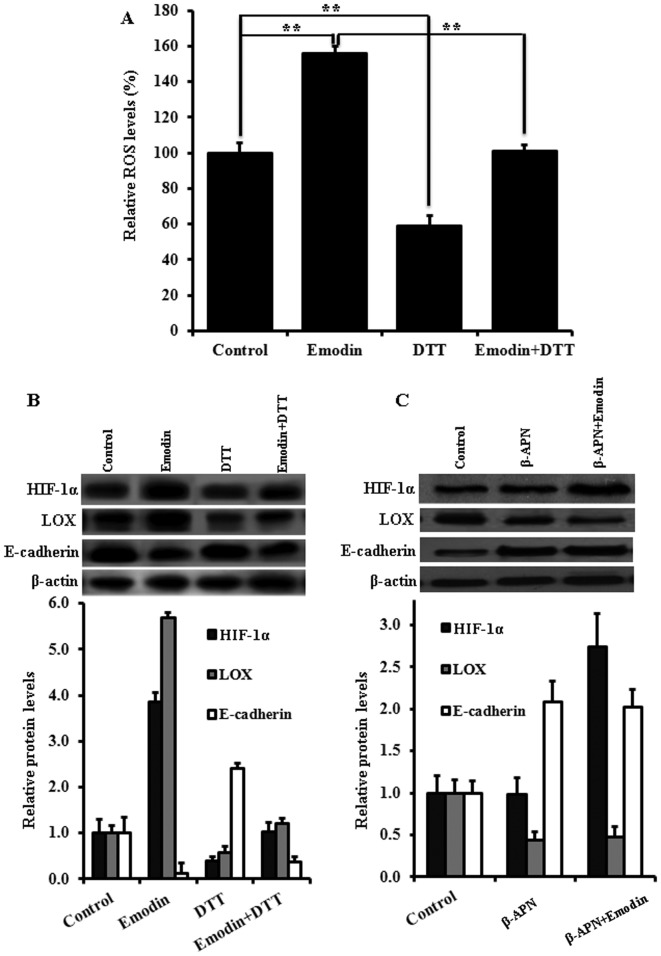
Effect of ROS on HIF-1α, LOX and E-cadherin expression. (A) Assessment of intracellular ROS production in SKOV-3 cells using DCFH-DA method. Cells were treated with 50 μM emodin for 4 h or 5 mM DTT for 2 h or the combination, and the green fluorescent intensity reflecting ROS levels was quantified by flow cytometry. Data are expressed as relative ROS levels to that in the untreated control. Values are means ± SD of 3 independent experiments performed in duplicate. **P<0.01. (B) Representative western blotting showing the expression of HIF-1α, LOX and E-cadherin in SKOV-3 cells after the above indicated treatments; the histogram shows the mean level of the protein determined from 3 independent experiments expressed as the fold-change relative to that in the untreated control cells after normalization to β-actin. (C) Representative western blotting showing the expression of HIF-1α, LOX and E-cadherin in SKOV-3 cells exposed to 100 μM β-APN for 4 h or 100 μM β-APN plus 50 μM emodin for 4 h; the histogram shows the mean level of the protein determined from 3 independent experiments expressed as the fold-change relative to that in the untreated control cells after normalization to β-actin. ROS, reactive oxygen species; LOX, lysyl oxidase; DCFH-DA, 2,7-dichlorodihydrofluorescein diacetate.